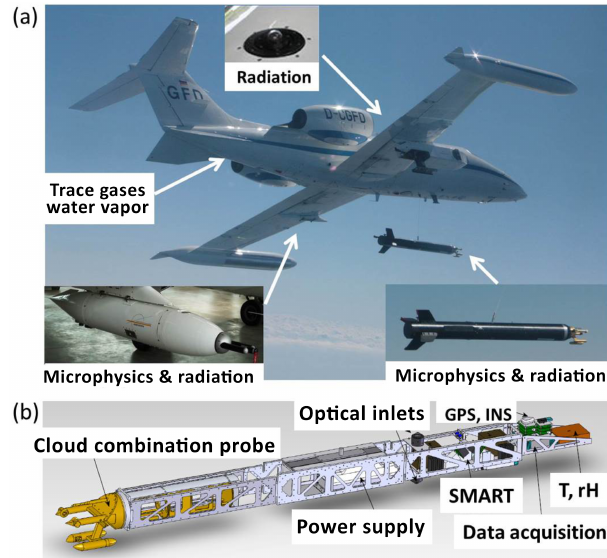
Figure 2. (a) Assembly of the research aircraft Learjet 35A, the towed AIRTOSS, and the wing pod containing instruments mea- suring radiation, microphysical parameter, water vapor, and trace gases. (b) Sketch of the AIRTOSS